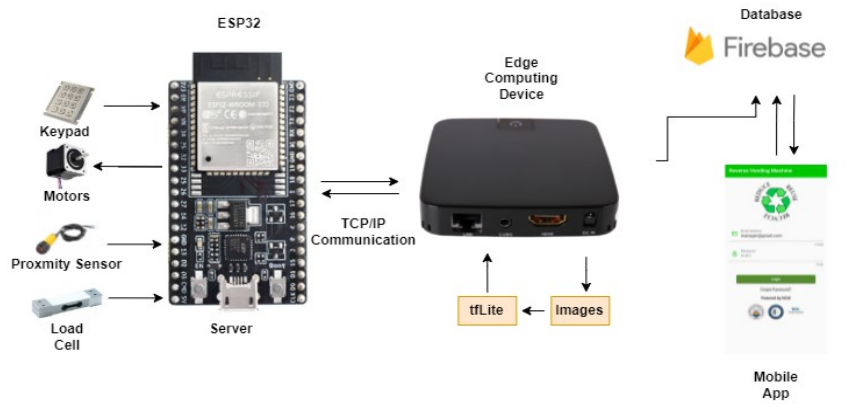
Figure 5. Communication block